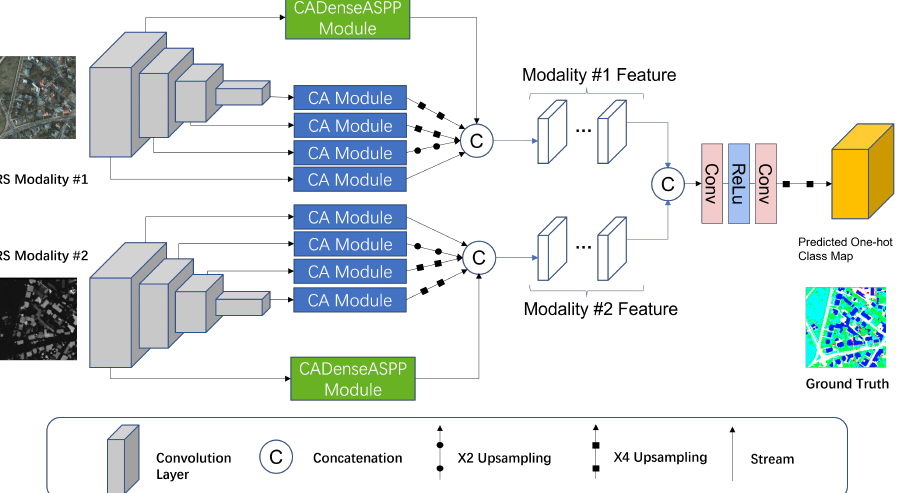
Figure 4. Attention-based multi-modal image fusion network (AMM-FuseNet). Two encoders are applied for two modalities, respectively. For each modality, there are two extractors used in parallel. Skip connections from the encoders to the decoder are used in the